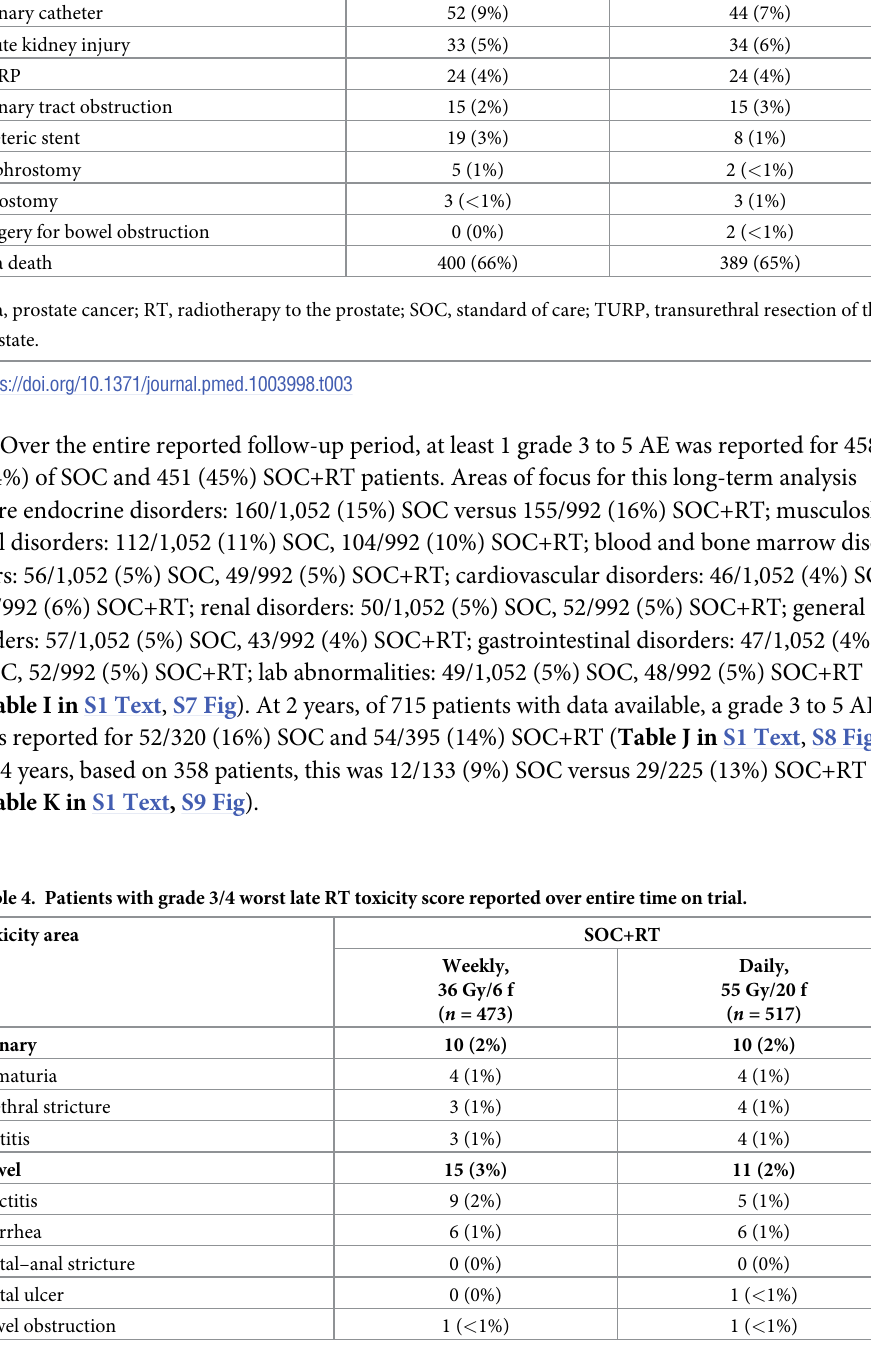
Table 3. First symptomatic local event reported (patients with event reported). Type of event SOC ( n = 608)